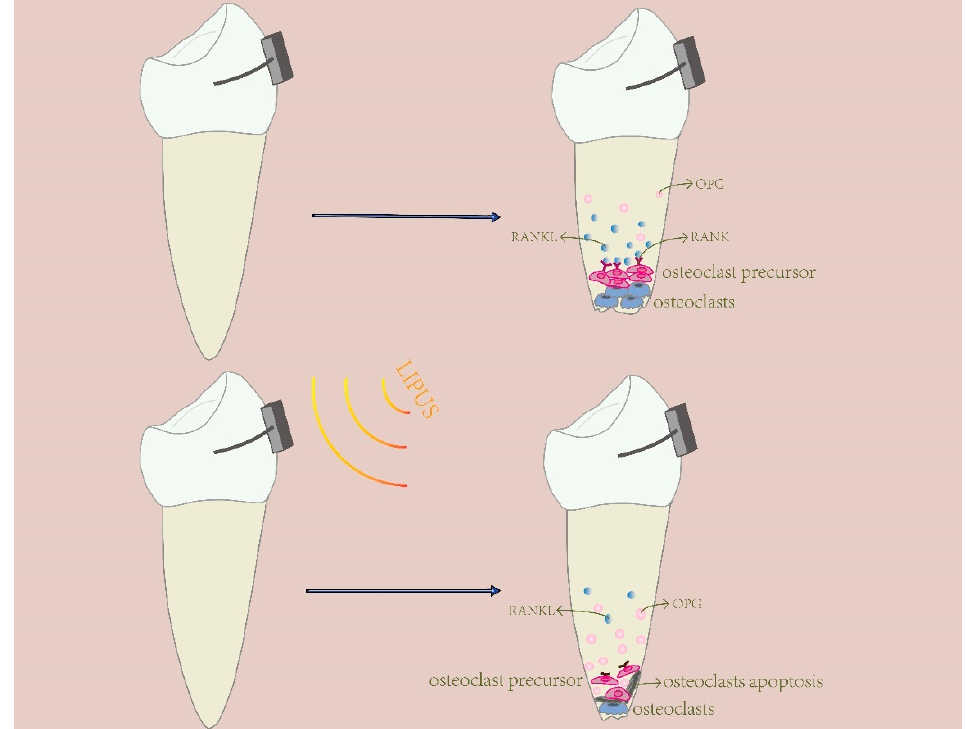
Figure 5. LIPUS inhibits further exacerbation of OITRR by affecting the ratio of RANKL and OPG. During OITRR, the ratio of RANKL/OPG is high. The RANKL binds to RANK which exists in the osteoclast precursor and then the osteoclast precursor differentiates into osteoclasts. The growing osteoclasts lead to OITRR further aggravation. Through using LIPUS, the ratio of RANKL/OPG decreases which contributes to osteoclast apoptosis.